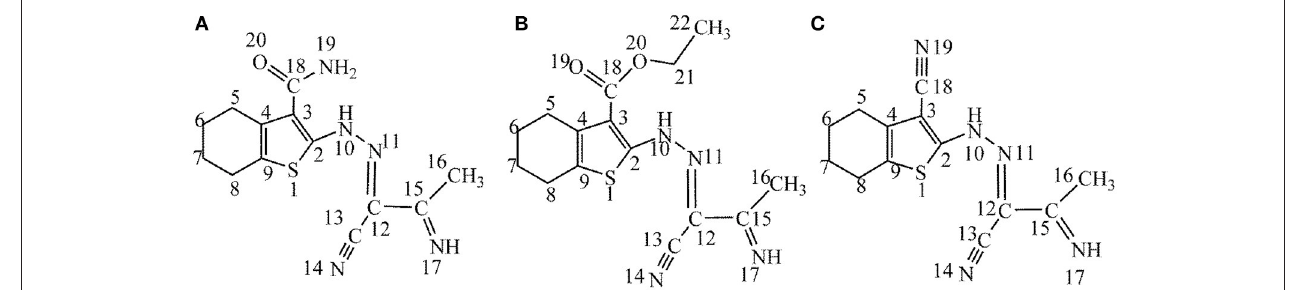
Frontiers in Chemistry |